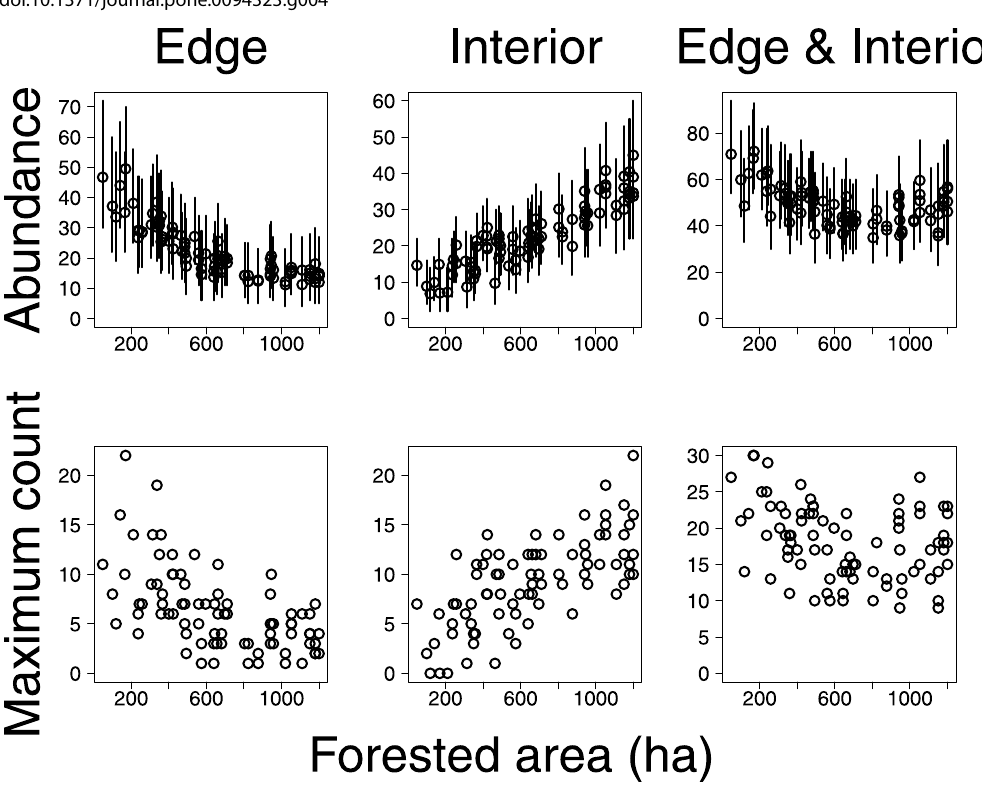
Figure 5. Maximum observed count of forest edge species, forest interior species, and forest edge and interior species and estimates of their abundance (posterior means and 95% credible intervals) at sample locations. Dashed line indicates the estimated relationship between mean abundance of birds and forested area.